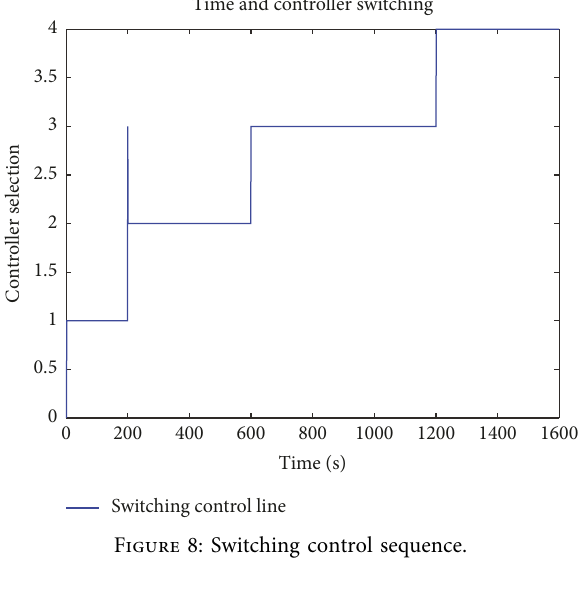
Figure 10: Control effect compared with the traditional PID